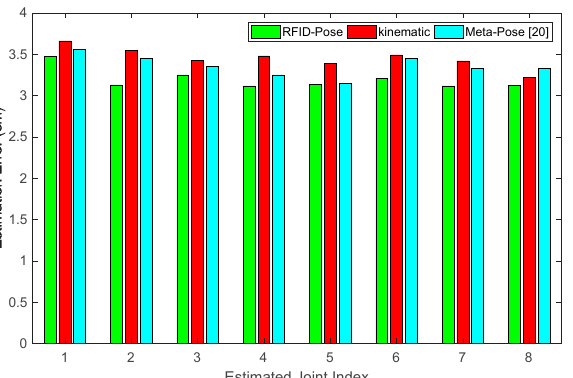
Figure 25. Estimation error for each human joint, numbered from 1 to 8 in the following order: head, right shoulder, left shoulder, torso, right hand, left hand, right foot, and left foot joints.